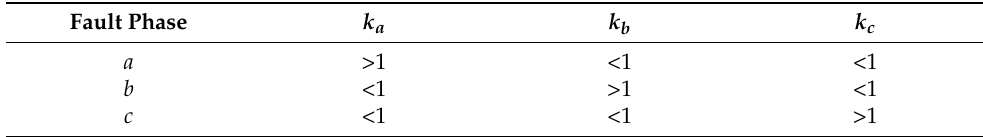
Table 1. Theoretical value of fault location indexes with